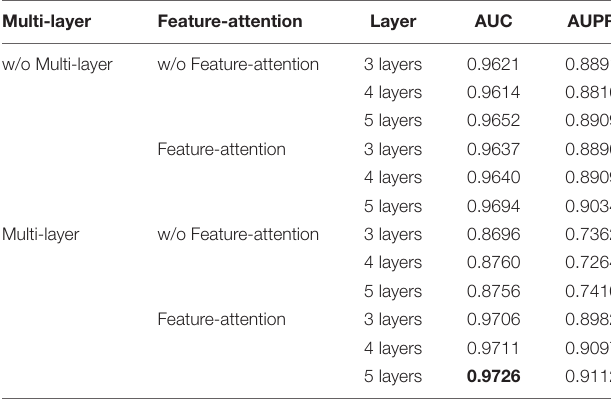
TABLE 5 | Ablation experiments on modules of feature-attention and multi-layer